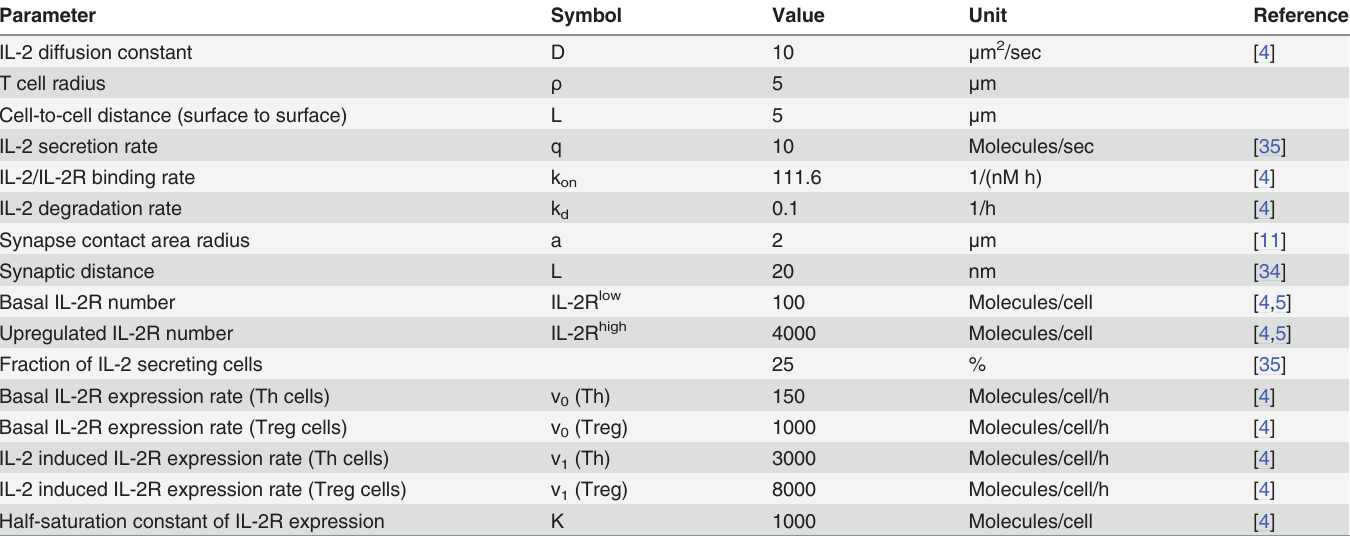
Table 1. Symbols and parameter